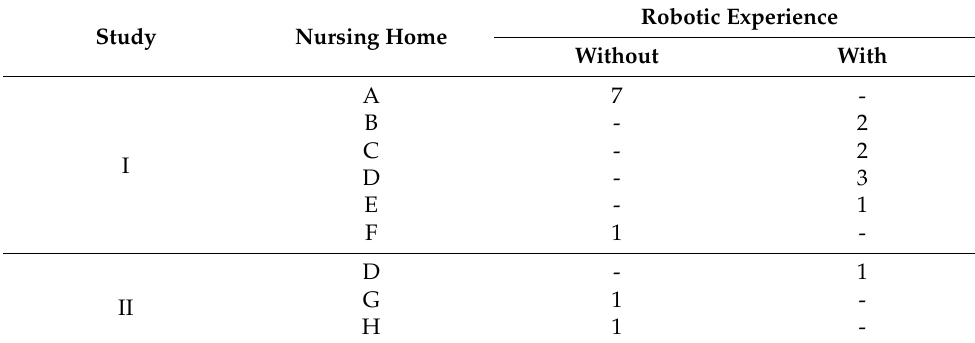
Table 1. Number of participants without and with robotic experience. Study Nursing Home